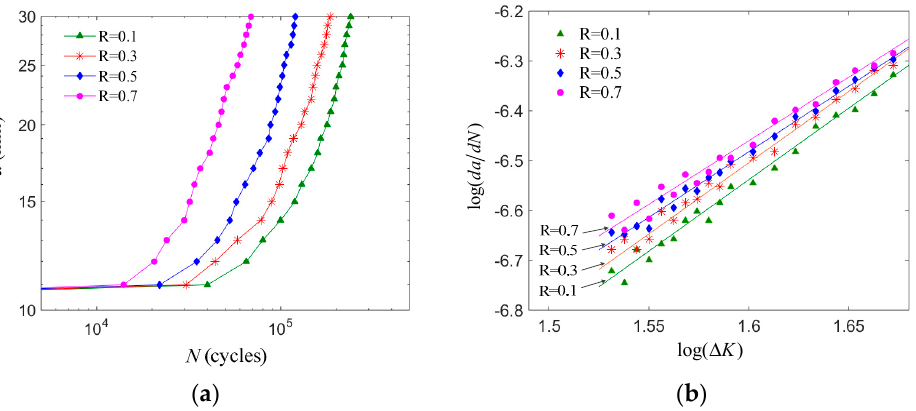
Figure 5. Fatigue crack growth curve under different stress ratios. ( a ) a − N curve; ( b ) FCP rate curve.